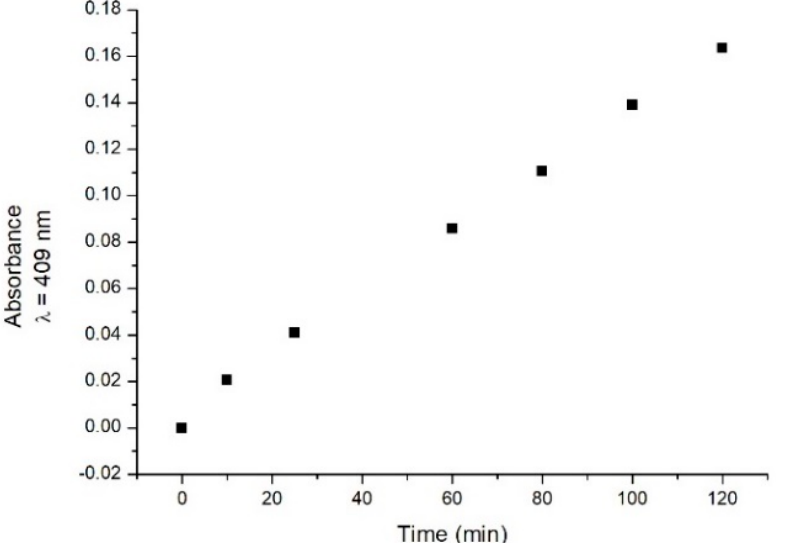
Figure 2. Time course behaviour of absorbance values at a fixed wavelength (409 nm) at different times after catechol addition.